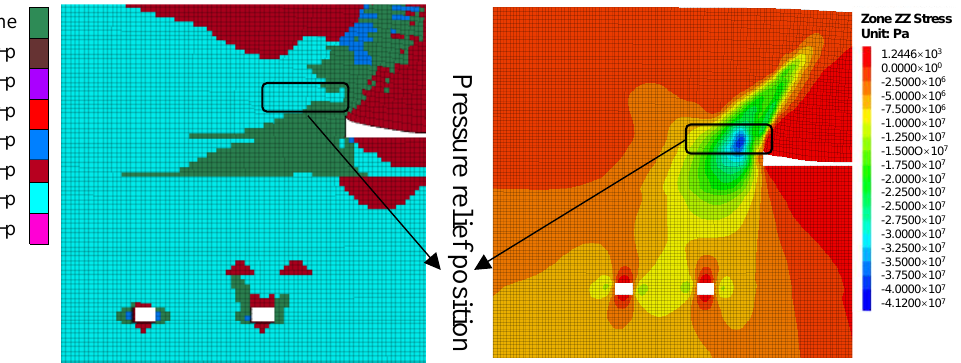
Figure 12. Top-cutting position at the first stage.